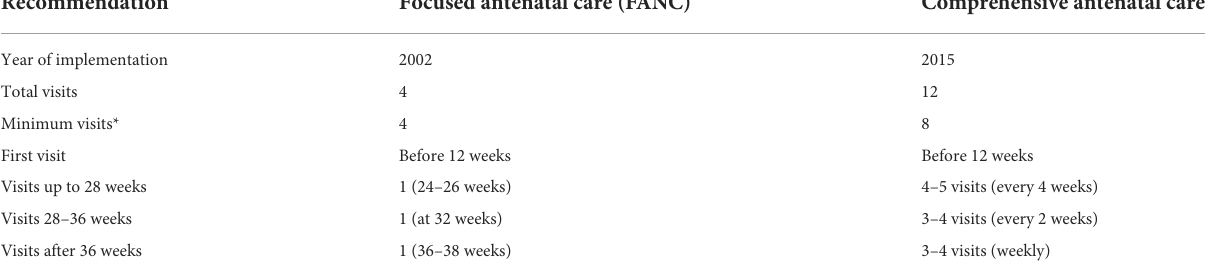
TABLE 2 Comparison of WHO antenatal care